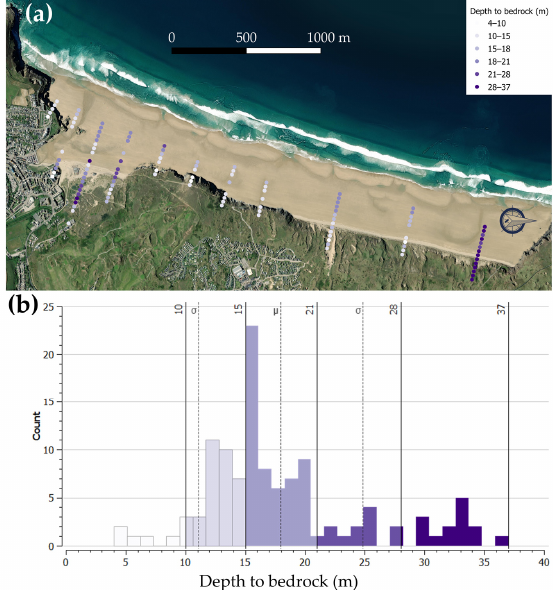
Figure 11. Depth to bedrock frequency spatial ( a ) and frequency distribution ( b ) obtained from the PSS sampled at Perranporth Beach. The vertical lines in (b) represent the max and min value for each colour group. colour